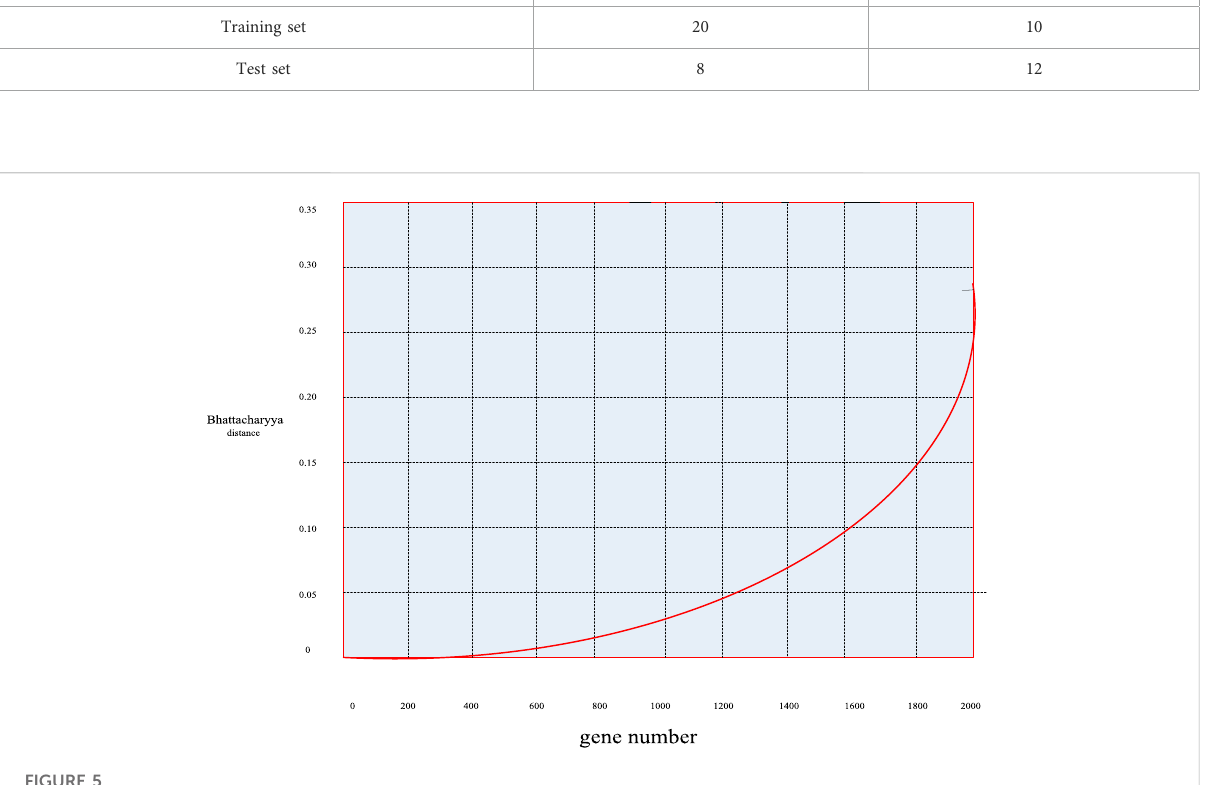
FIGURE 5 Bhattacharyya distance distribution curve of breast cancer